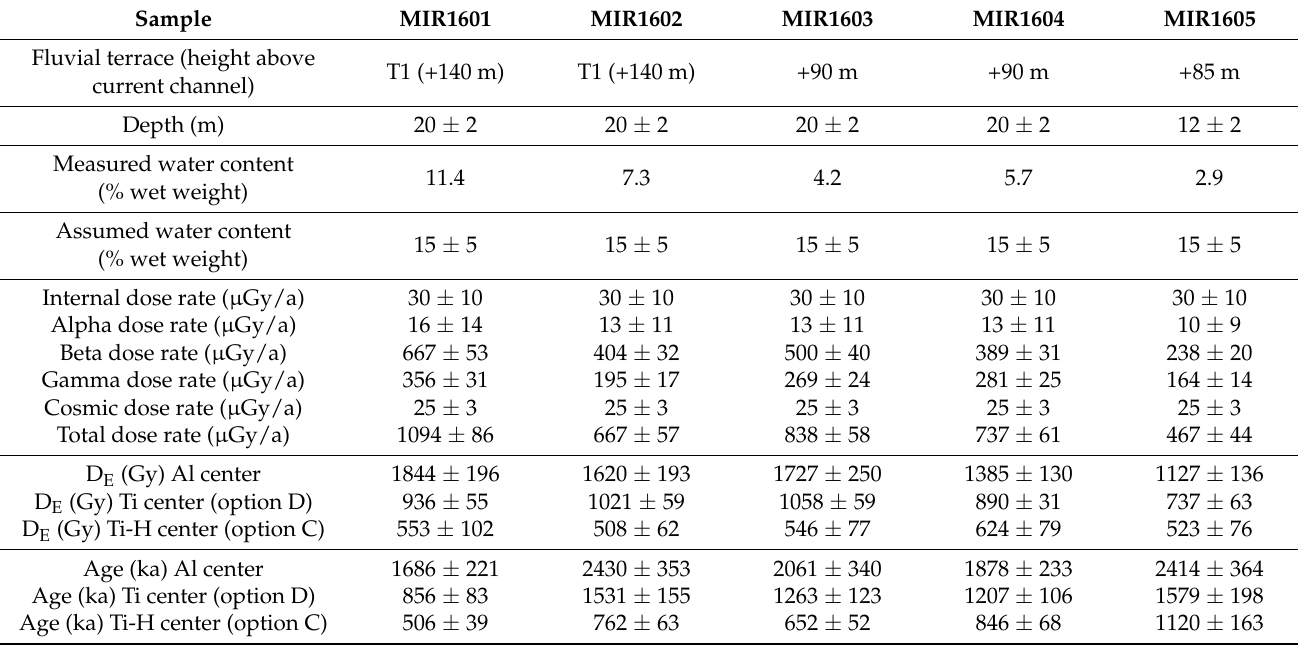
Table 5. Detail of ESR age estimates and dose rate components. Errors are 1 sigma. Note that D E errors are a combination of fitting errors (from Tables 1 and 2) and gamma source dose rate